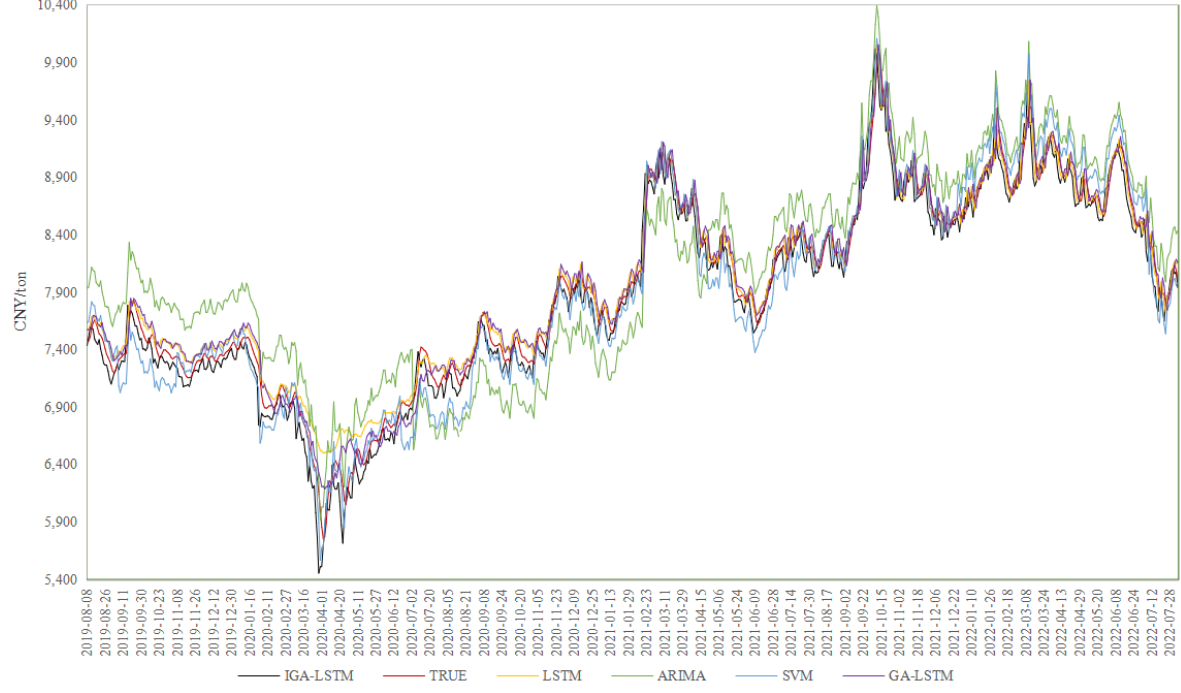
Figure 4. LLDPE futures price forecast results.